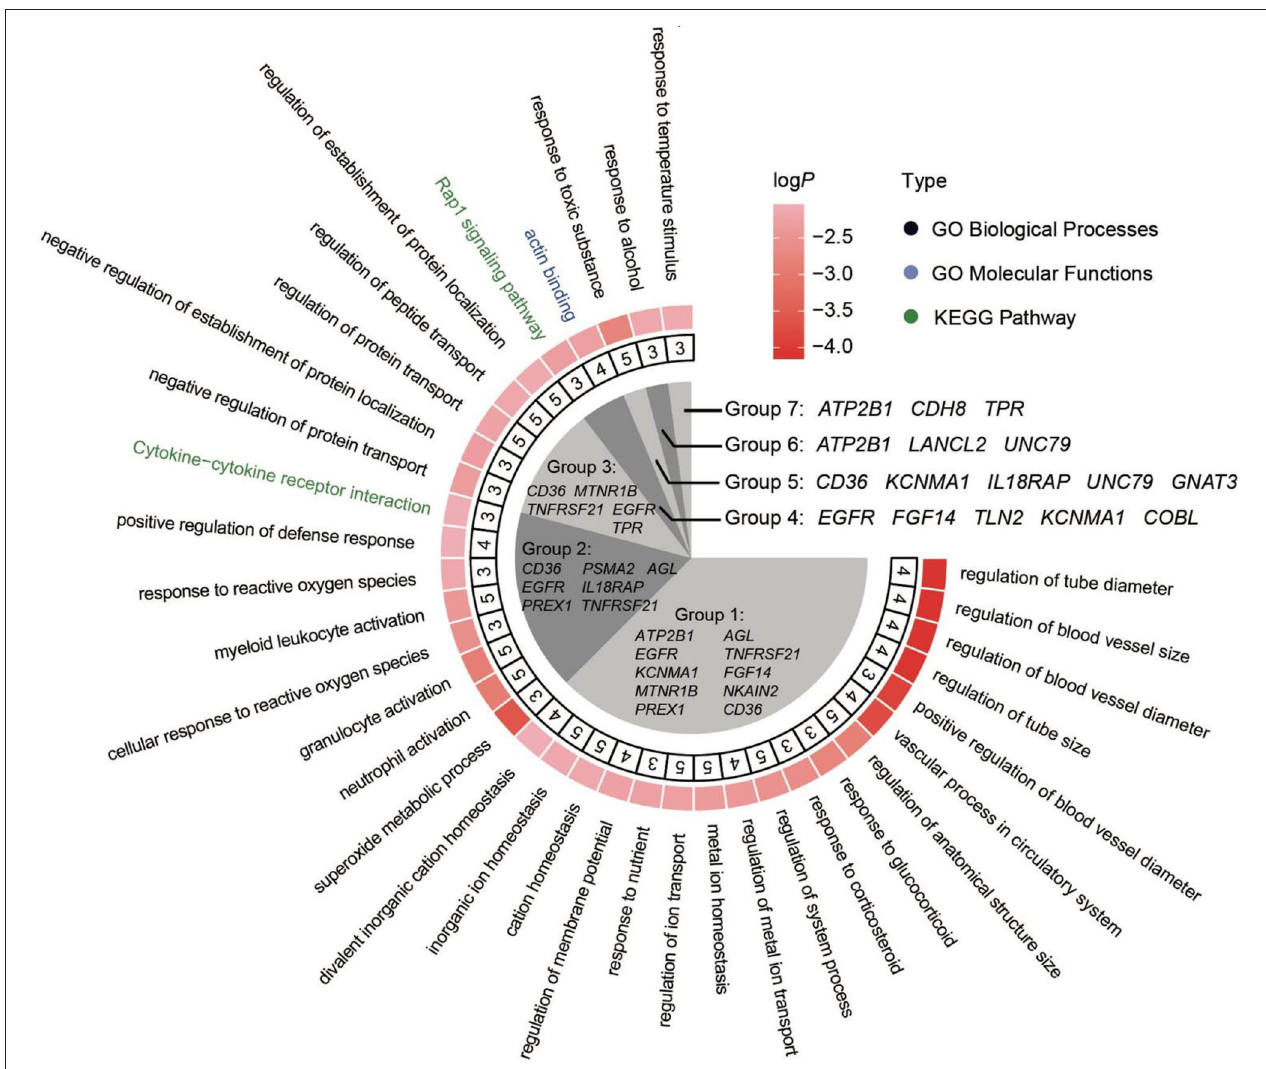
FIGURE 6 | Enrichment analysis of the genes under selection. All enrichment terms can be divided into seven groups. The genes involved in these groups were marked in the inner fan. The second annulus represents the number of genes that are involved in the specific